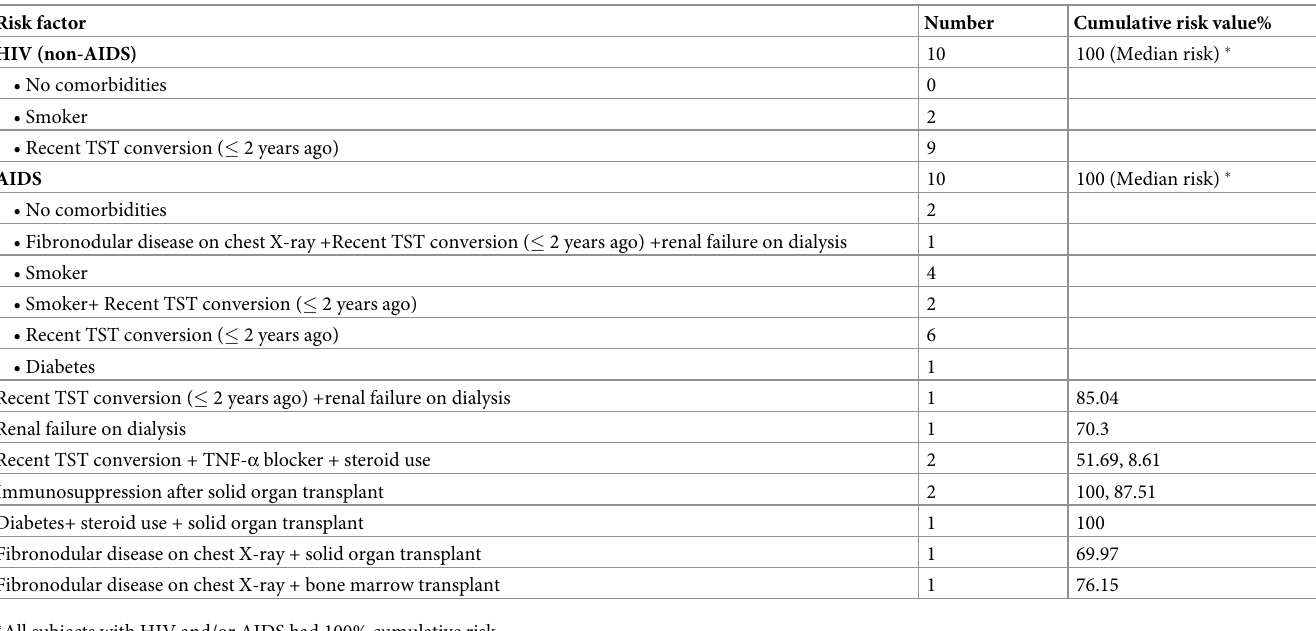
Table 2. Distribution of medical risk factors for progression to active TB in subjects in the High (50–100% cumulative risk) group. Risk factor